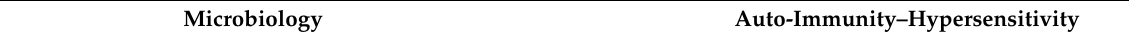
Table 2. Proposition for a second-line biological diagnostic work-up for patients with acute respiratory failure, bilateral opacities on chest X-ray and PaO 2 /FiO 2 ratio under 300 mm Hg after exclusion of cardiogenic pulmonary edema, and no diagnosis after first-line check-up.